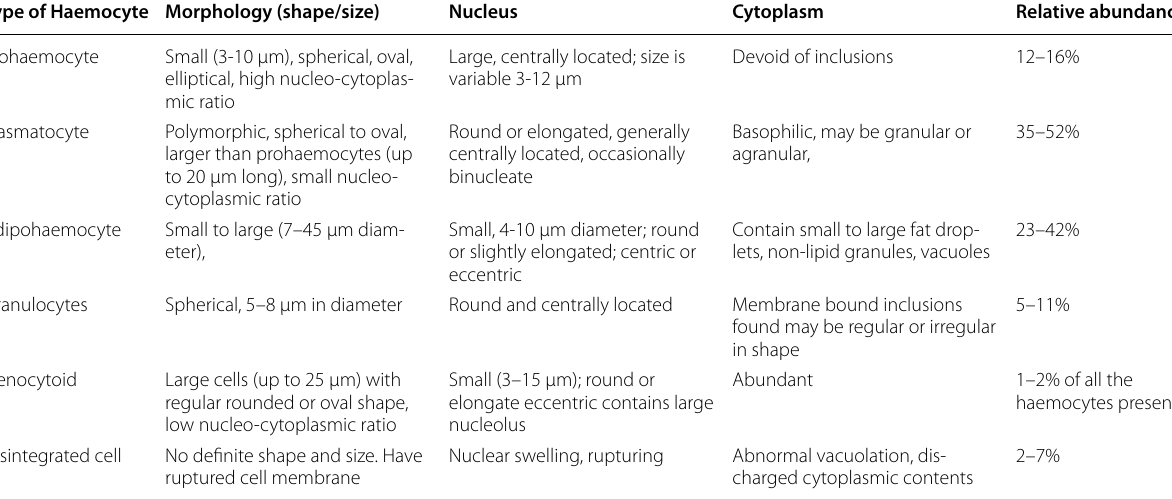
Table 2 Characteristics of Haemocytes Present in Fifth Instar Nymphs of Dysdercus koenigii Type of Haemocyte Morphology (shape/size)